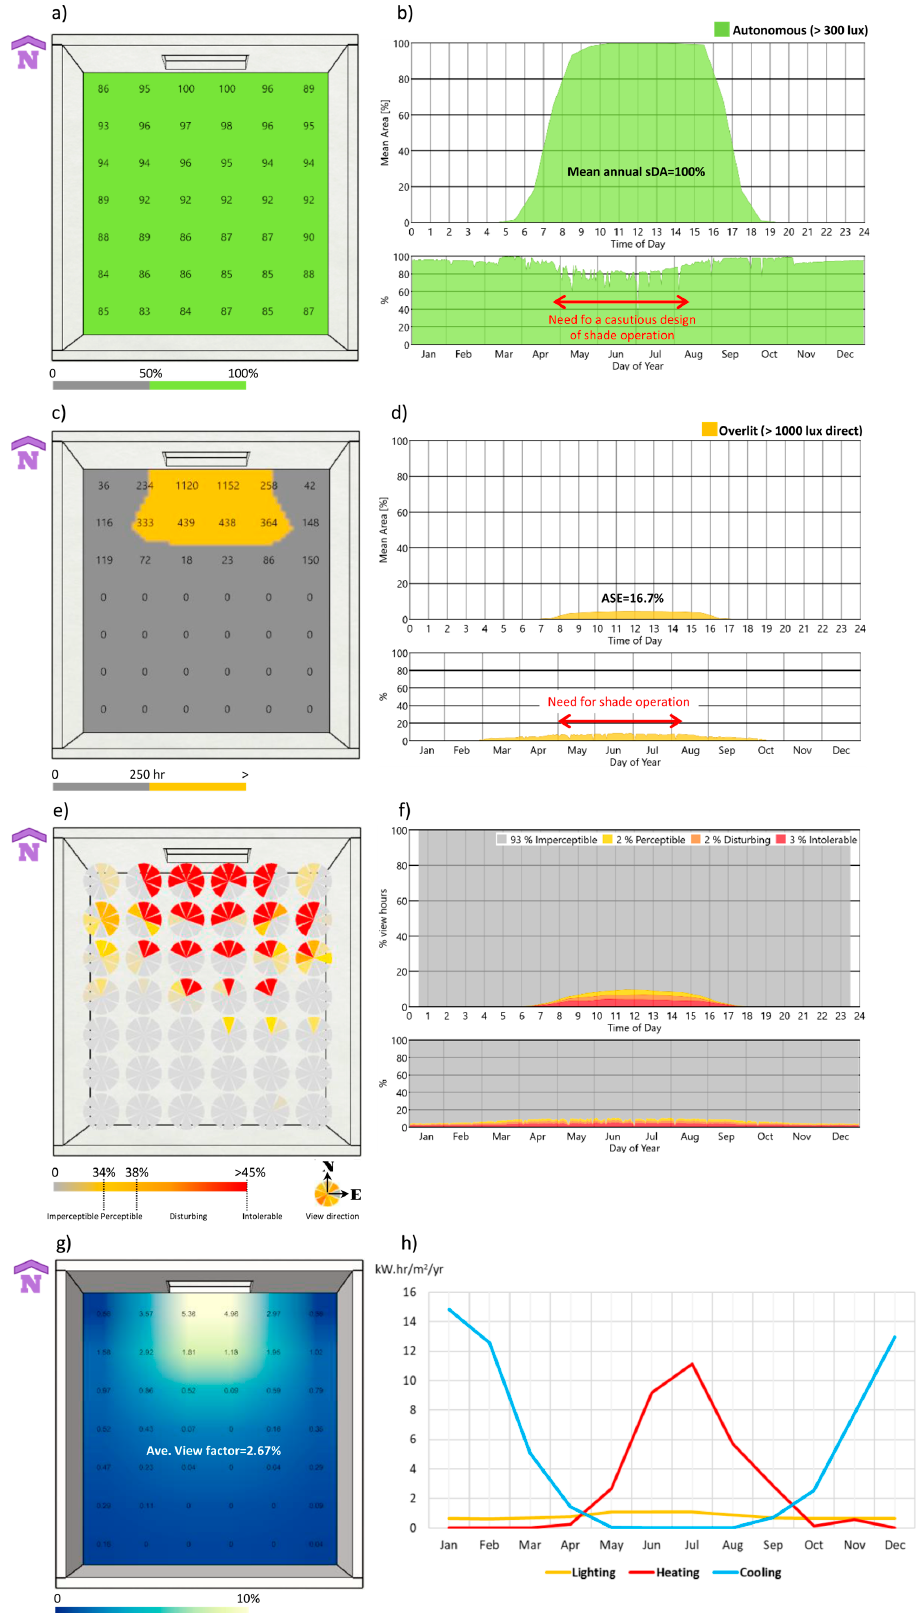
Figure 7. Yearly study for no-shade window: ( a ) each sensor sDA (plan-view); ( b ) mean daylight autonomy versus time; ( c ) each sensor ASE (plan-view); ( d ) mean overlit area versus time; ( e ) each sensor DGP in 8 directions (plan-view); ( f ) mean DGP versus time; ( g ) Sky-View factor; ( h ) monthly